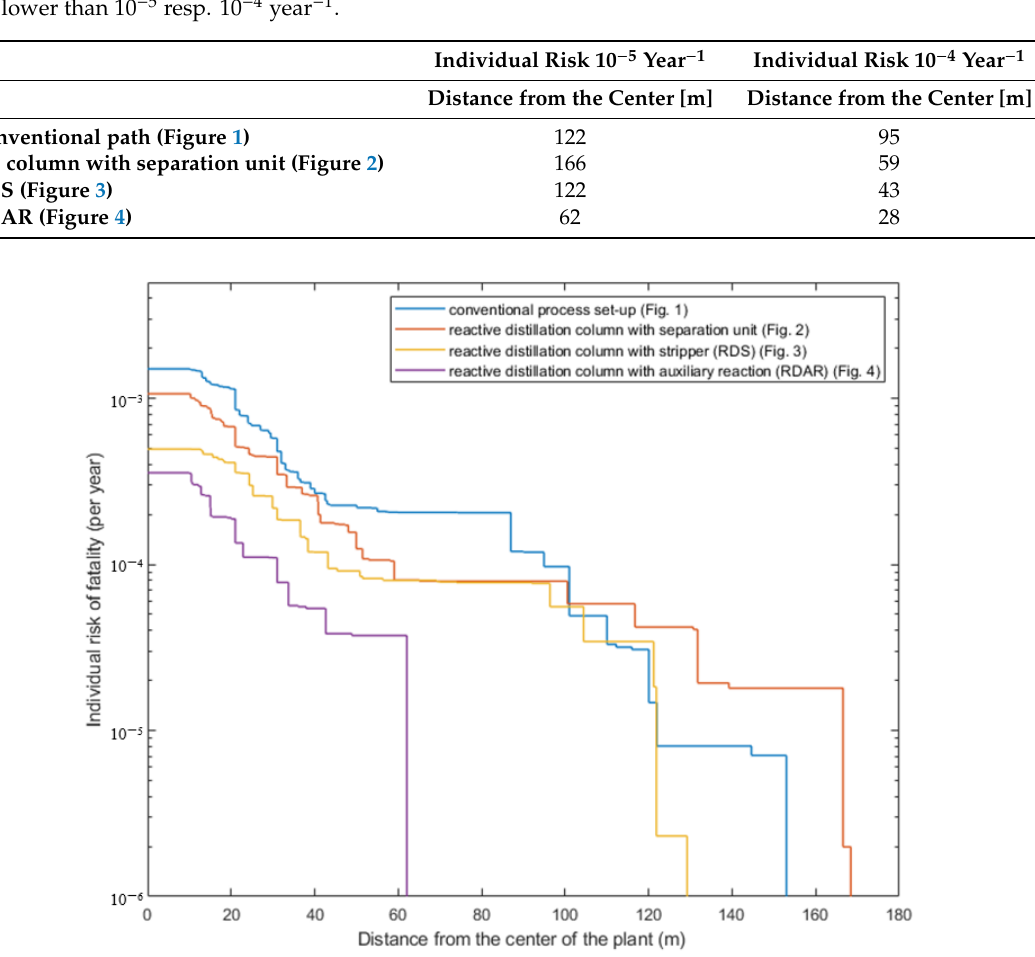
Figure 7. Individual risk of fatality estimation for presented case